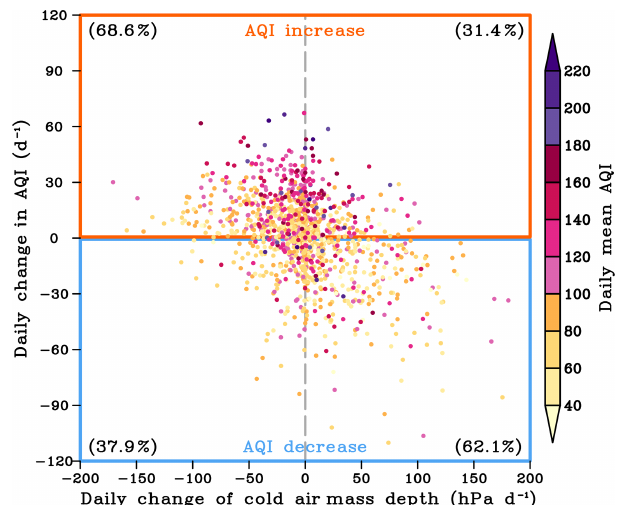
Figure 2. Relationship between the daily changes in the AQI and the cold air mass depth. The daily change is estimated by the current day minus the preceding day. The colors of the dots denote the daily mean cold air mass depth on the current